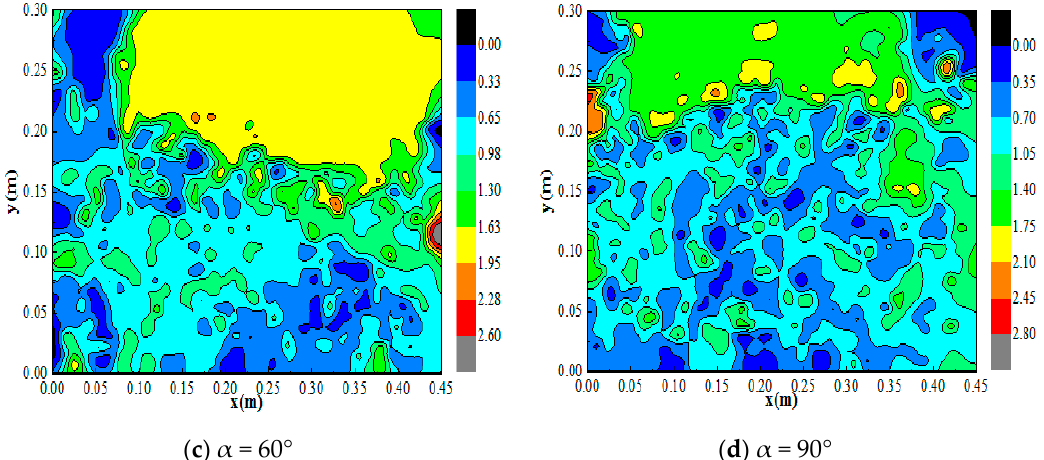
Figure 15. Distributions of the surface flow field of zone 1 under different configurations, ( a ) α = 30°;